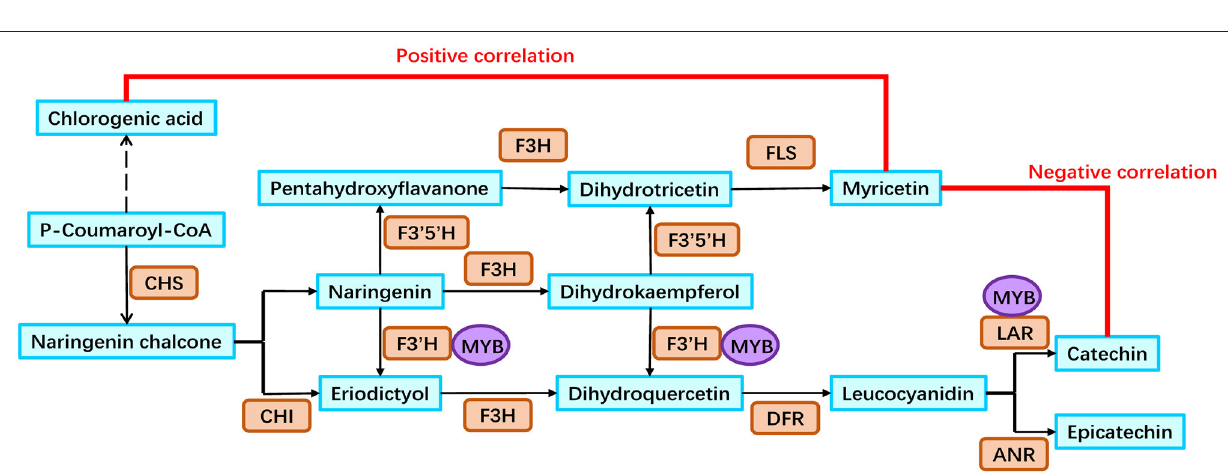
This included 13 metabolites, 11 genes that were annotated to encode eight enzymes, and one MYB transcription factor.